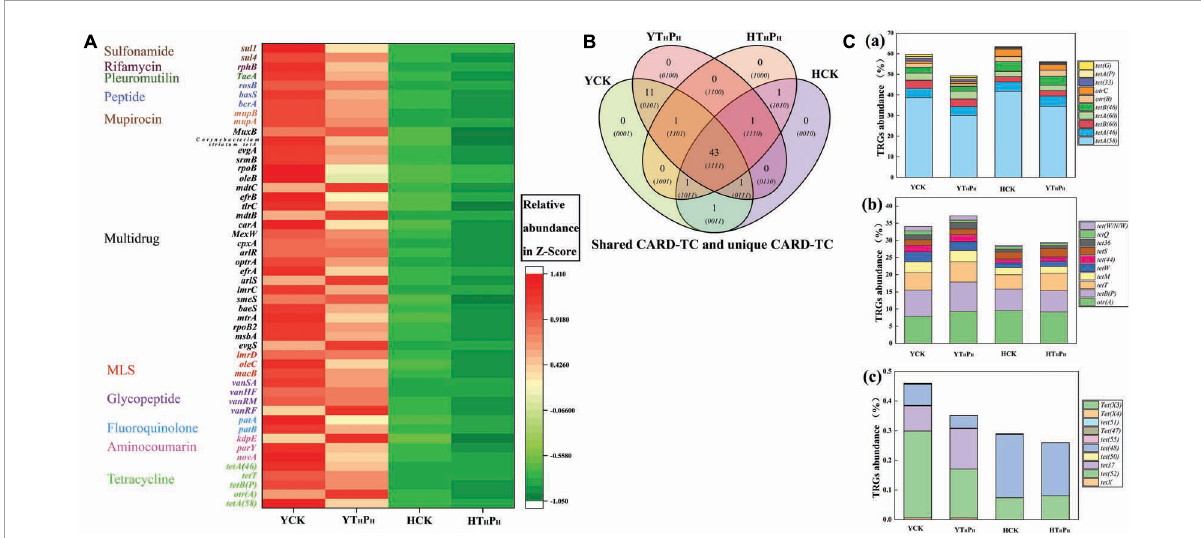
FIGURE6 (A) Heatmap showing abundances of 50 background ARGs in 4 sediments. (B) Shared TRGs and unique TRGs. (C) Relative abundances of TRGs among sediment of ecosystems, (a) Efflux pump genes, (b) Ribosomal protection protein genes, (c) TC inactivation genes. YCK means the pig farm sediments alone treated for 30 days, HCK means the riverbed sediments alone treated for 30 days, YT H P H means the pig farm sediment system contain 180 mg · L - 1 of TC and 125 mg · kg - 1 of g-C 3 N 4 for 30 days, HT H P H means the riverbed sediment system contain 180 mg · L - 1 of TC and 125 mg · kg - 1 of g-C 3 N 4 for 30 days.